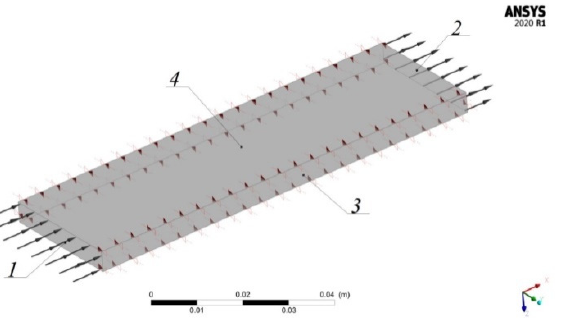
Figure 6. Boundary conditions: 1—«Inlet»; 2—«Outlet»; 3—«Symmetry»;